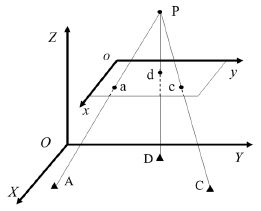
Figure 3. Principle of single image space resection, where A, B, and C are known control points on the ground, and a, b, and c are corresponding points in the image.